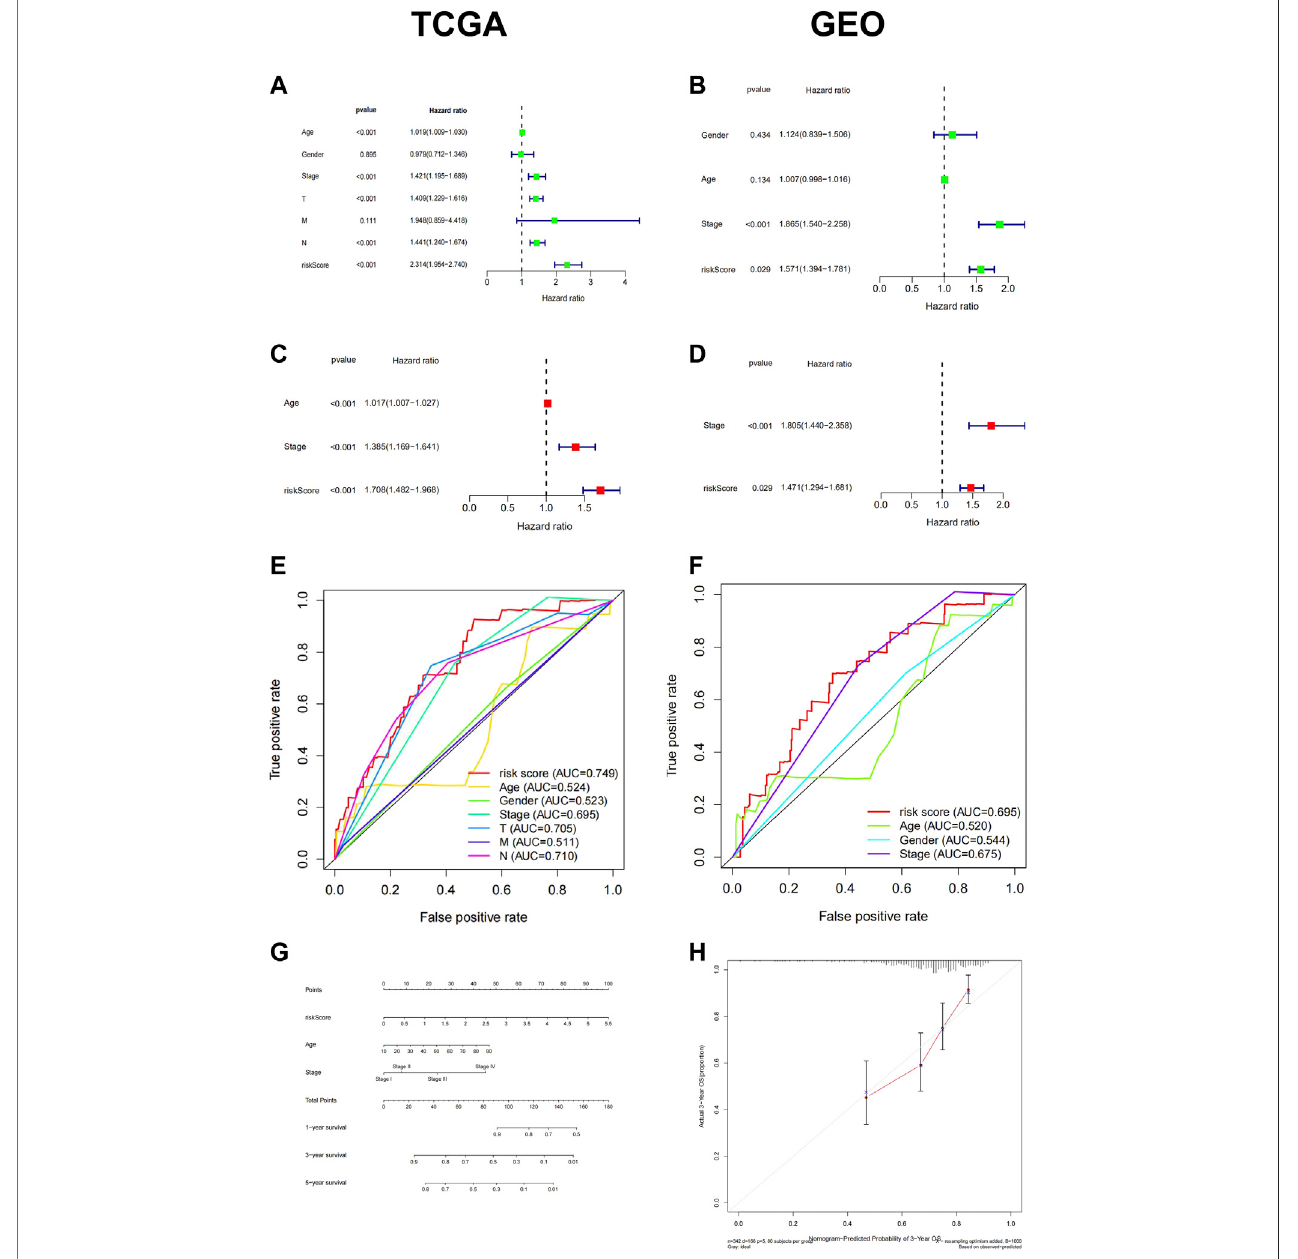
FIGURE 4 | Cox regression and a nomogram of the signature of 6-FRGs predicting survival in melanoma patients. Univariate Cox regression analysis and multiple Cox regression analysis con fi rmed RiskScore could predict the prognosis of patients both in TCGA (A,C) and GEO (B,D) independently. The ROC curve showed the high prediction accuracy of this model in TCGA (E) and GEO (F) . (G) A nomogram of the 6-FRGs signature for 1, 3, 5-year survival prediction in the TCGA dataset. (H) The 3-year OS calibration curve showed good calibration in the training set.